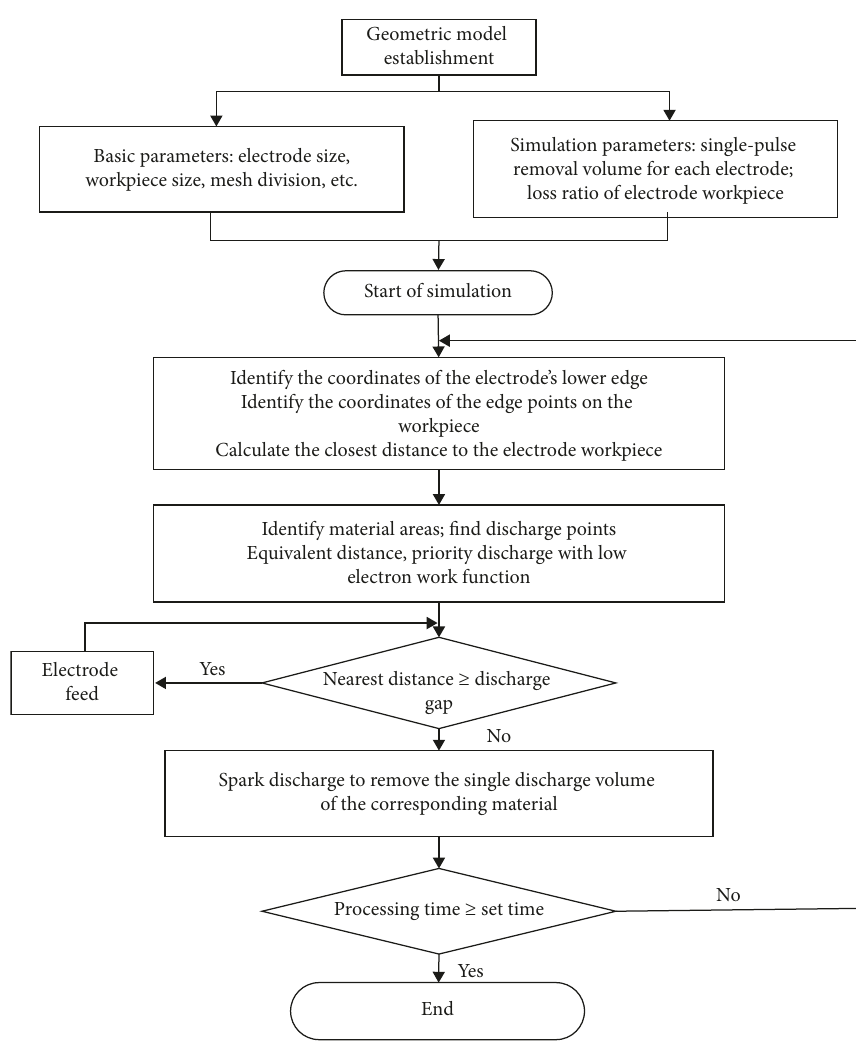
Figure 4: Multimaterial electrode simulation flowchart.